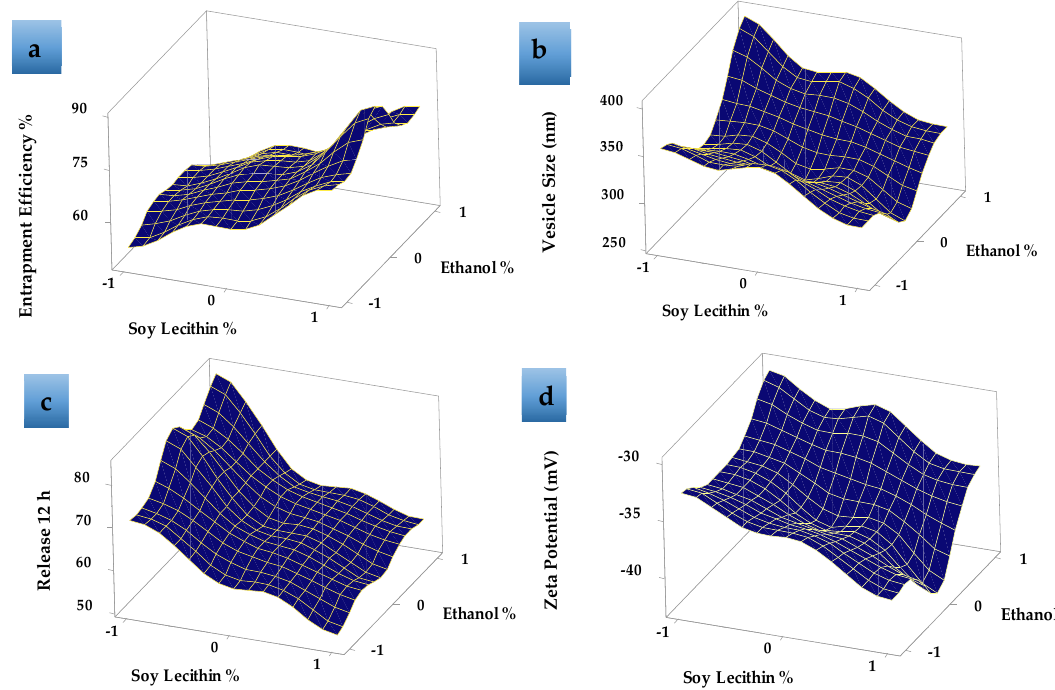
Figure 4. Response surface plots effects of different formulation factors on ( a ) entrapment efficiency %, ( b ) vesicle size (nm), ( c ) release 12 h, and ( d ) zeta potential (mV).